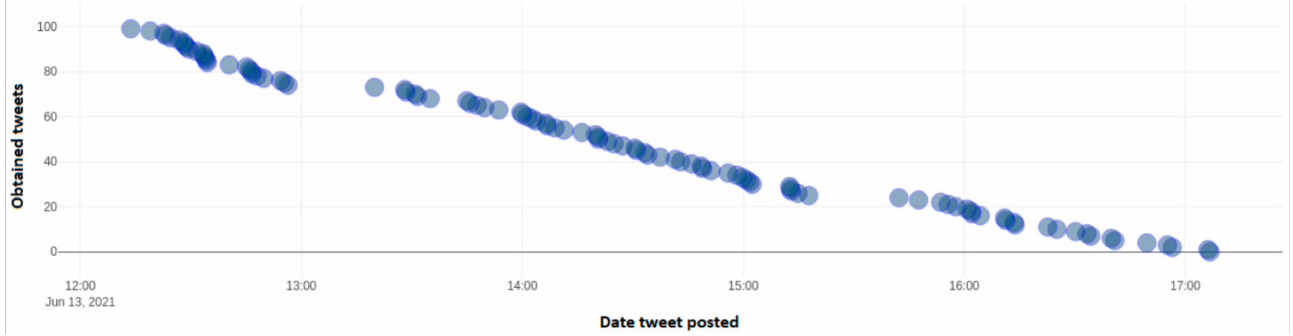
Figure 18. Mined tweets based on negative hashtag (#N ∆ _ ξεϕτ ´ ι λε ς ) (100 tweet sample) for New Democracy party.